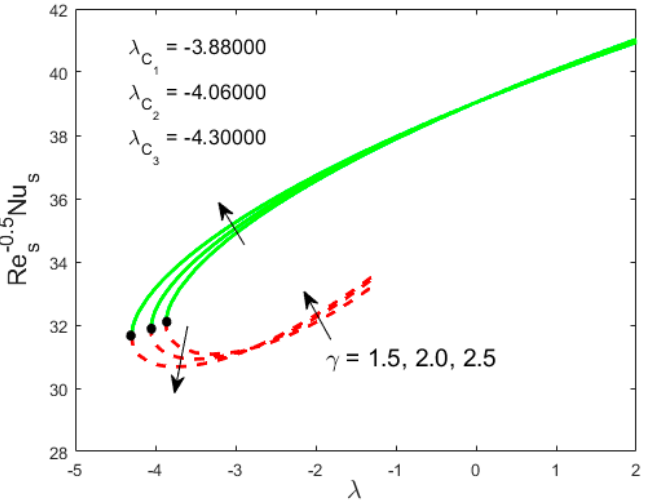
γ 0.5 Re C versus λ . on s F